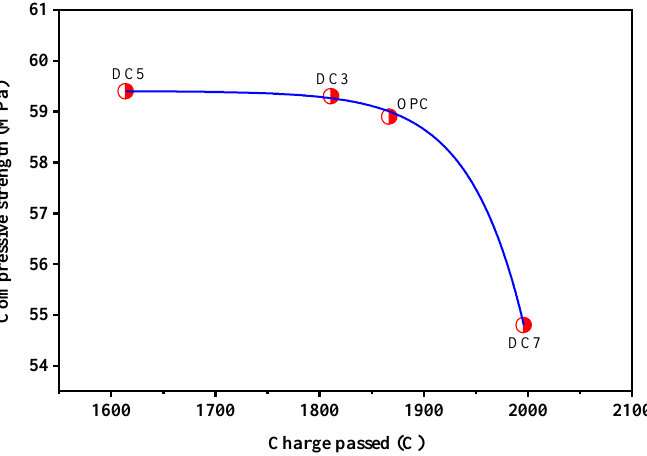
Figure 12. Relationship between charge passed and compressive strengths of concrete samples.